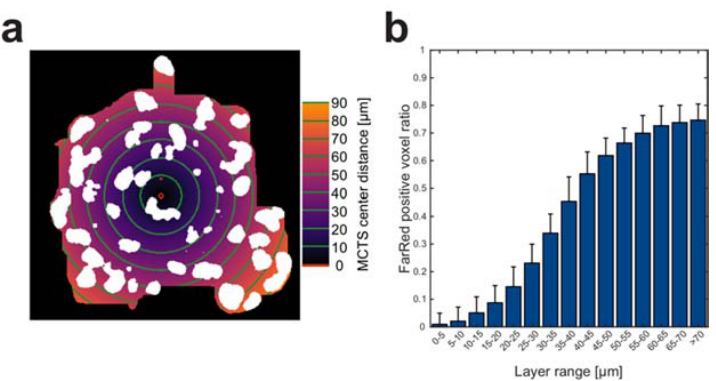
Figure 3. Cellular arrangement in core ‐ shell spheroids. Each MCTS (n = 20) was divided into 5 μ m thick concentric layers (every 10 μ m marked by green lines) based on distance (colormap indicates distance away from center) from the MCTS center (red dot) ( a ). The ratio between Far Red positive voxels against total number of voxels was calculated in all layers ( b ). Scale bar is 20 μ m.